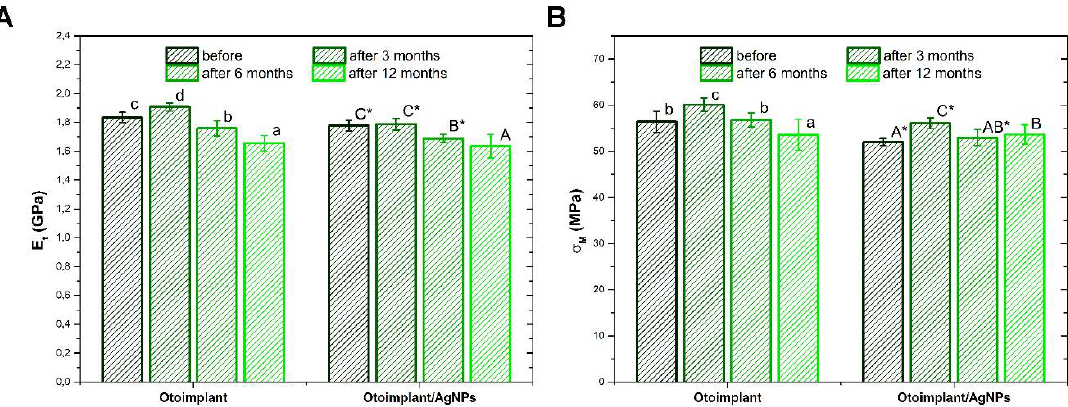
Figure 3. Mechanical properties of the Otoimplant and Otoimplant/AgNPs before and after 3-, 6-, and 12-month incubation in deionized water: Young’s modulus E t ( A ) and tensile strength σ M ( B ). Statistically significant differences ( p < 0.05) between specific incubation times are marked a–d for Otoimplant and A–C for Otoimplant/AgNPs, respectively. Statistically significant differences ( p < 0.05) between Otoimplant and Otoimplant/AgNPs at specific incubation time are marked *.